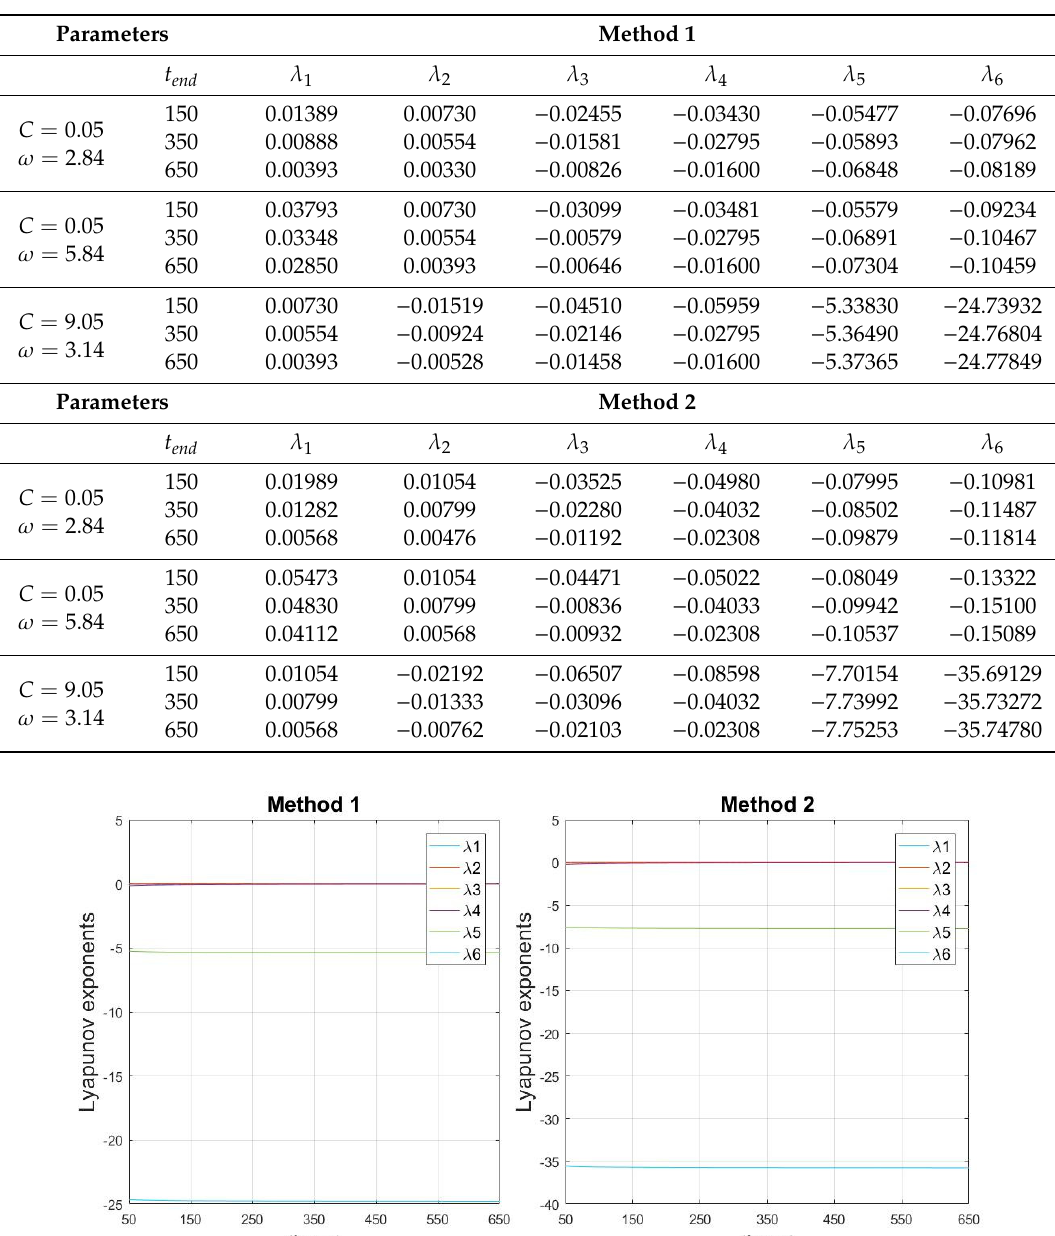
Table 5. Spectra of Lyapunov exponents for the system with second mutation of rigid pendulum.